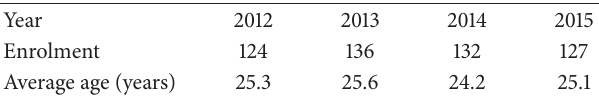
Table 2: Showing the summary of students’ enrolment and average students’ ages during the four-year period of the